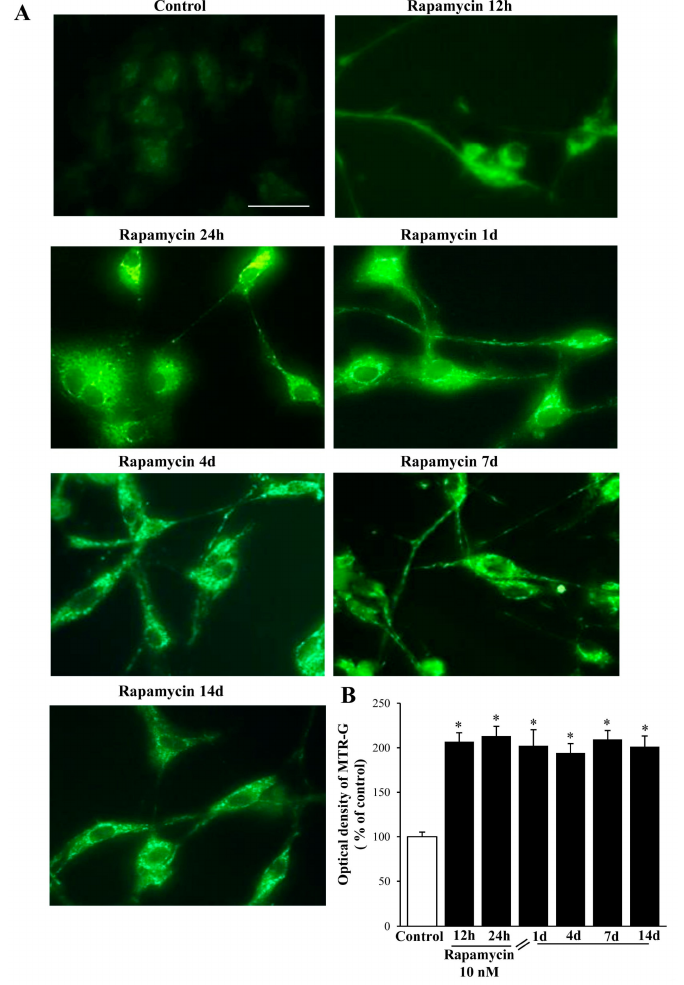
Figure 6. Rapamycin increases MitoTraker-Green (MTR-G) in U87MG cell line. ( A ) Representative fluorescent microscopy of U87MG cells stained with 250 nM of the mitochondrial MTR-G dye (green). ( B ) Graph reports fluorescence at di ff erent time intervals. Values are the mean percentage ± S.E.M. from 50 cells per group. * p ≤ 0.05 vs. Control. Scale bar = 25 µ